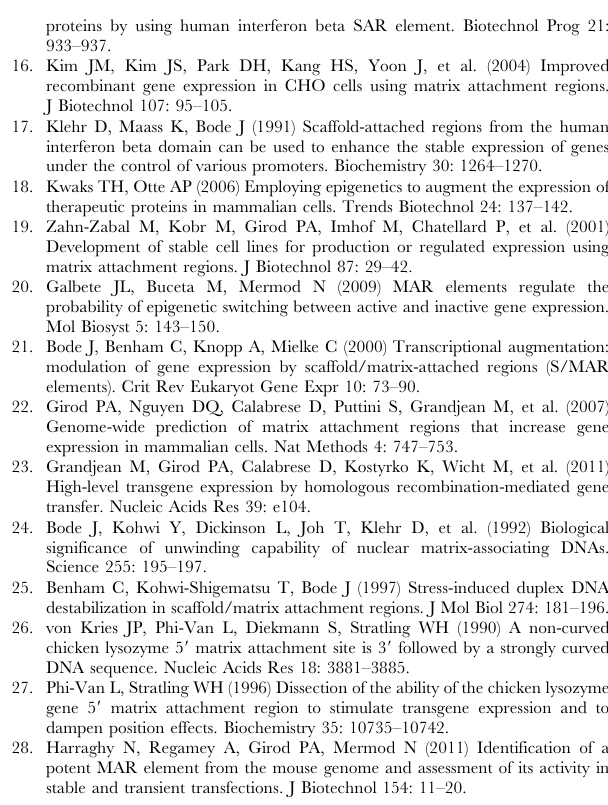
Figure S3 Effect of negative control DNA sequences on the occurence of silent and high expressor cells. Spacer DNA of various lengths (3.6 kb to 200 bp), consisting of part of the utrophin or luciferase coding sequences, were used to replace the full-length MAR 1–68 or its deletions derivatives. The proportion of silent and high-expressor cells were determined and displayed as described in the legend to Fig. 2. Figure S4 Effect of transcription factor DNA binding motifs on the occurence of silent and high expressor cells. Oligonucleotides corresponding to DNA sequence motifs predicted to act as binding sites for the SATB1, Hox, Gsh, Fast-1 and CEBP transcription factors by the MatInspector software were mixed and inserted randomly downstream of the extended AT- rich core and upstream of the SV40 promoter of the GFP expression vector depicted in Fig. 1A. The number and order of the binding motifs were determined by DNA sequencing, as indicated, and various combinations containing from 2 to 9 motifs were randomly selected for analysis. The proportion of silent and high-expressor cells were determined and displayed as described in the legend to Fig. 2. Significant differences relative to the construct containing the extended AT core alone are indicated by stars above each bar, whereas line-associated stars indicate significant differences between the indicated constructs (Student test, P , 0.05). Figure S5 Effect of negative control DNA sequences on the average GFP fluorescence and transgene copy number. Spacer DNA of various lengths (3.6 kb to 200 bp), consisting of part of the utrophin or luciferase coding sequences, were used to replace the full-length MAR 1–68 or its derivatives.